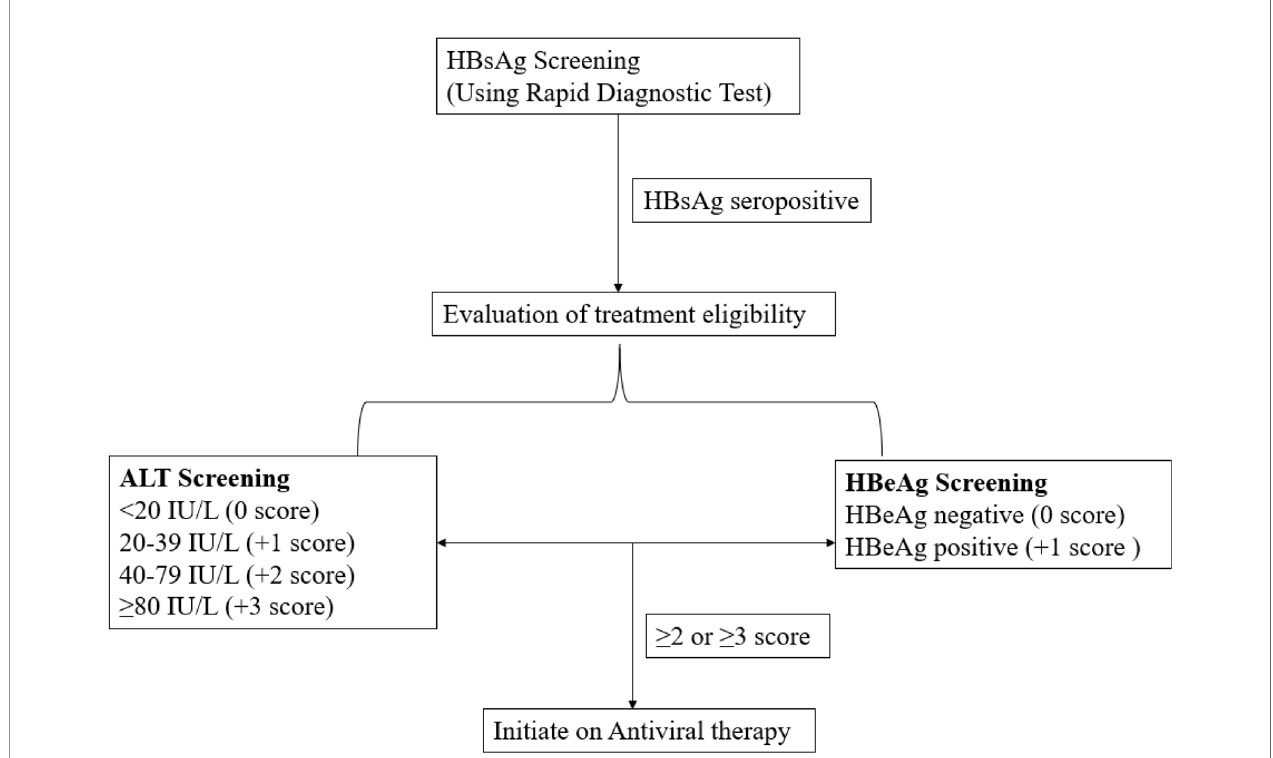
FIGURE 1 | The novel simpli fi ed score of the TREAT-B